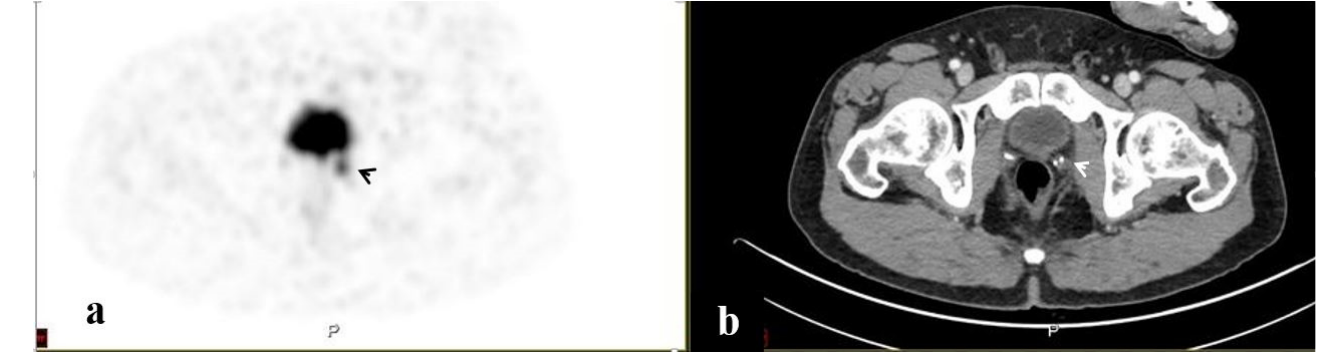
Figure 4. A PSMA-avid lesion in the pelvis at the prostatic bed. 68Ga-PSMA scan, PET ( a ) and CT ( b ) axial slices demonstrating focally increased uptake in the pelvis at the prostatic bed on the left (arrows).